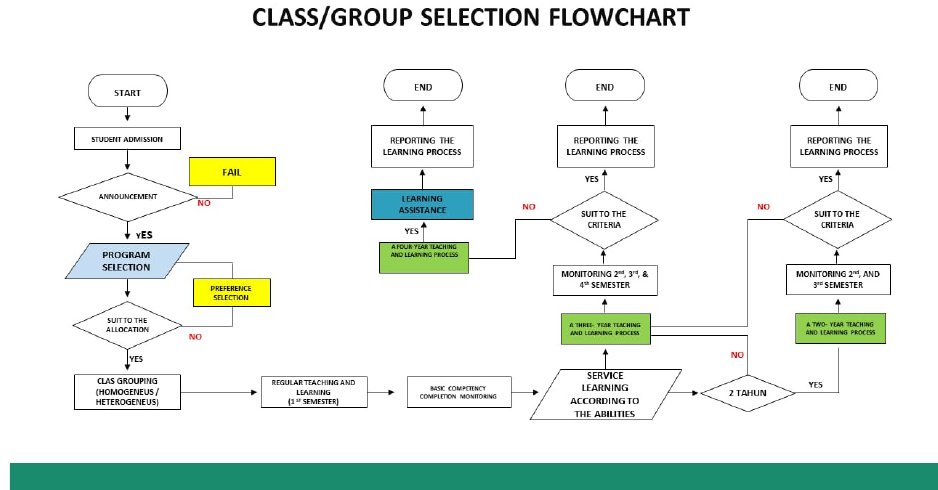
Figure 3. Class network flowchart.